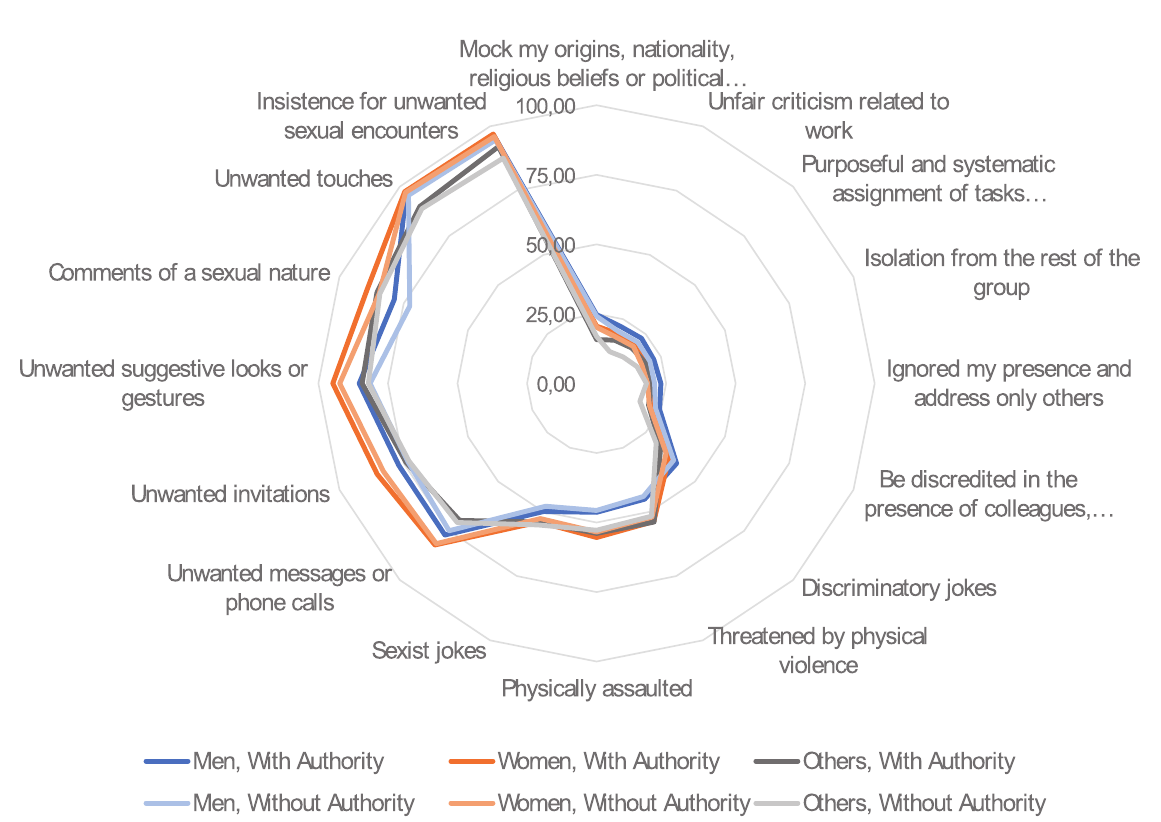
Figure 5. Percentage of students, professors, and staff who consider the above acts as sexual harassment separated by gender and the authority of the harasser. Full text of the summarized items: ”Purposeful and systematic assignment of tasks inferior or superior to your competences”, ”Mock my origins, nationality, religious beliefs, or political beliefs”, and ”Be discredited in the presence of colleagues, superiors, or subordinates”.